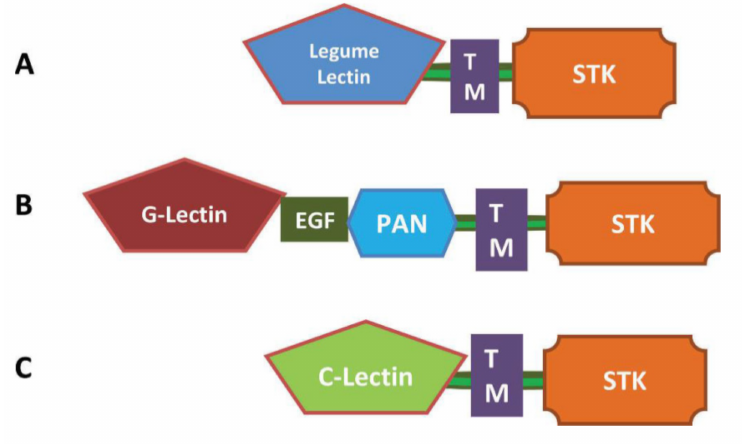
Figure 1. Line Model of the three Lectin receptor-like kinases (LecRLKs) [4]. ( A ) L-type LecRLKs; ( B ) G-type LecRLKs; ( C ) C-type LecRLKs. TM: transmembrane region; STK: cytoplasmic Serine / Threonine kinase domain. PAN: Plasminogen Apple Nematode domain; EGF: Epidermal Growth Factor